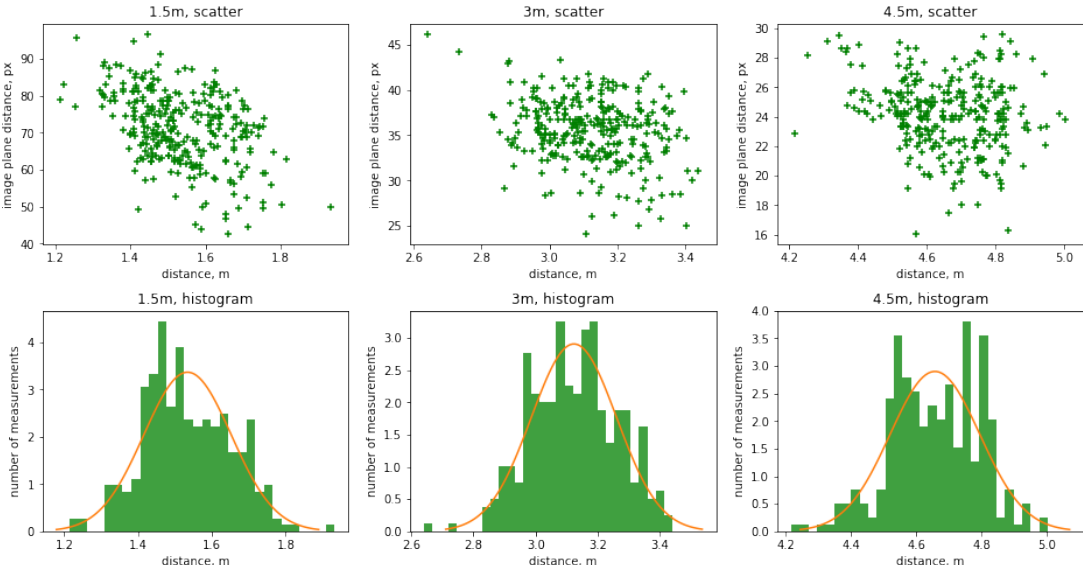
Figure 5. Scatter graphs and histograms for normality testing of the sensor measurements at the three key distances. The graphs in the top row show the distance in meters (horizontal axis) versus pixels (vertical axis). The graphs in the bottom row shows the number of bins (horizontal axis) versus frequency (vertical axis). All measurements performed with interacting subjects. Red line represents ideal normal distribution given the µ and σ of the